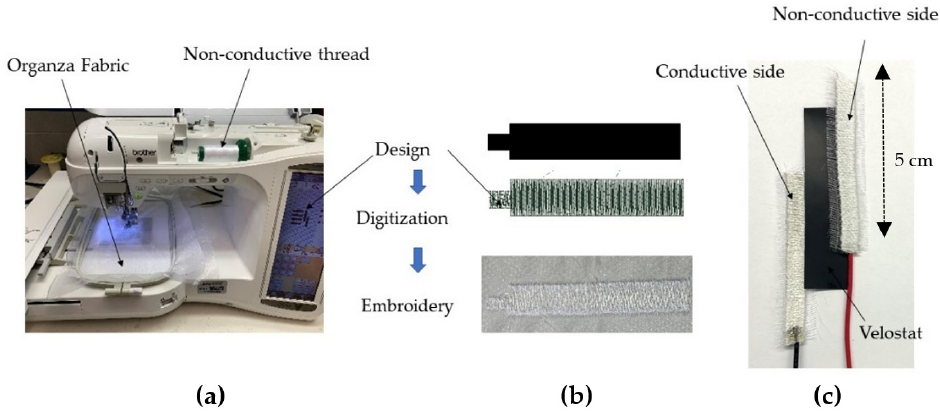
Figure 5. Embroidery Process with a Brother 4500D Embroidery Machine, outlining the formation of a thru-mode embroidered FSR. ( a ) embroidery machine; ( b ) embroidery process; ( c ) thru-mode embroidered FSR.